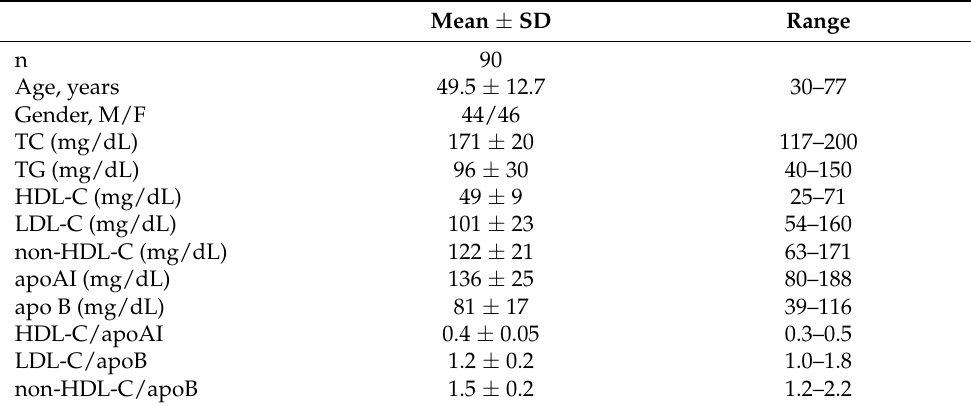
Table 1. Serum lipid parameters and apolipoproteins of the study